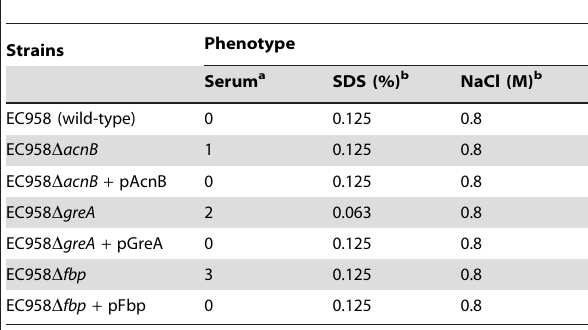
Table 4. Complementation of selected